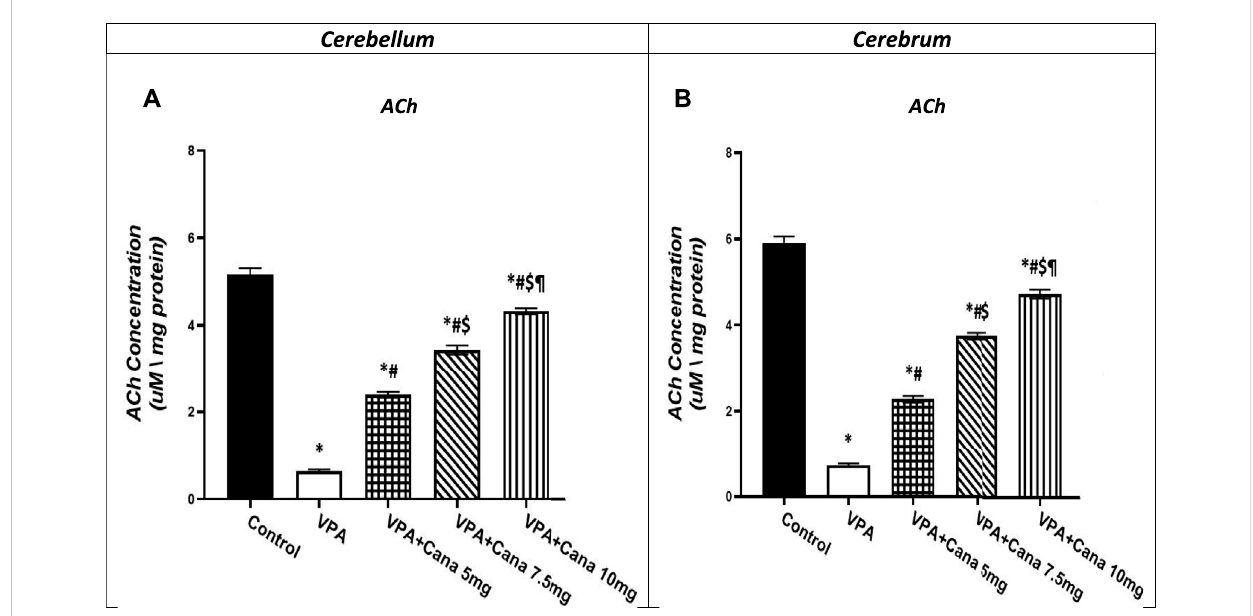
FIGURE 8 Effectofcanagli fl ozin(5,7.5,and10 mg/kg)oncerebellum (A) andcerebrum (B) tissuelevelofAChinVPA-inducedautisminrats.VPA:valproicacid, Cana:canagli fl ozin. Resultsareexpressedasmean±S.E.Mandanalyzedusingone-wayANOVAfollowedbyTukeyposthocmultiplecomparisonstest.* Compared to the corresponding Control group at P < 0.05, # Compared to the corresponding VPA group at P < 0.05, $ Compared to the